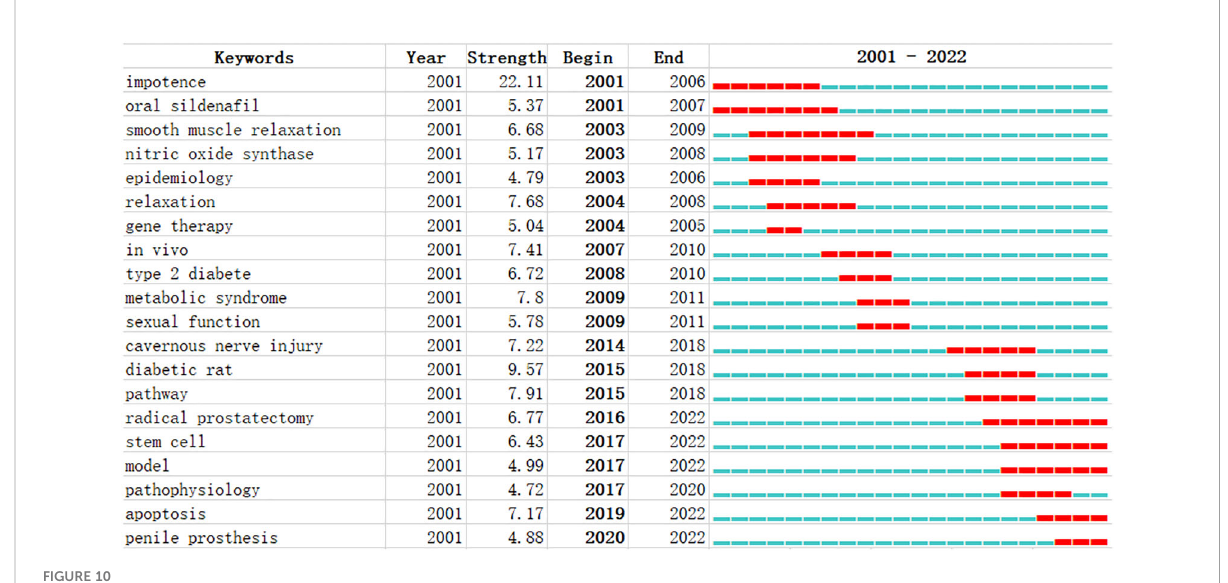
FIGURE 10 Keyword burst analysis using